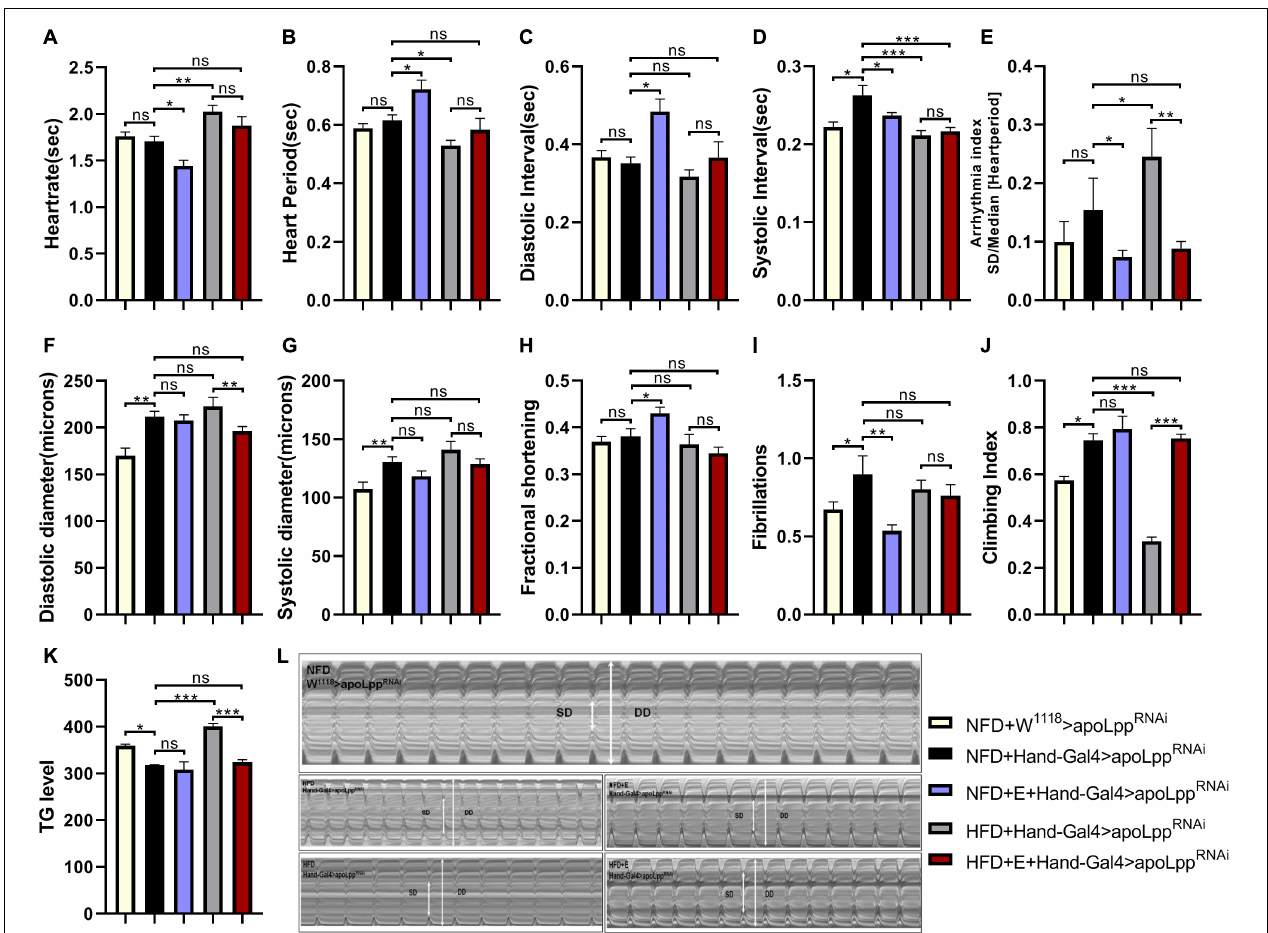
FIGURE 4 | Effect of cardiomyocyte-specific inhibition apoLpp on heart function, exercise capacity, and TG levels of each fly group. (A–I) Under different treatments, the M-mode indicators are HR, HP, DI, SI, AI, DD, SD, FS, and FL. All fruit flies were females, The sample sizes, NFD + w 1118 > apoLpp RNAi